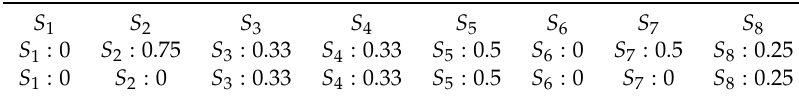
Table 8. File of cases for the solutions generated for the DAGs in Figures 2 and 3; where S n represents a generated